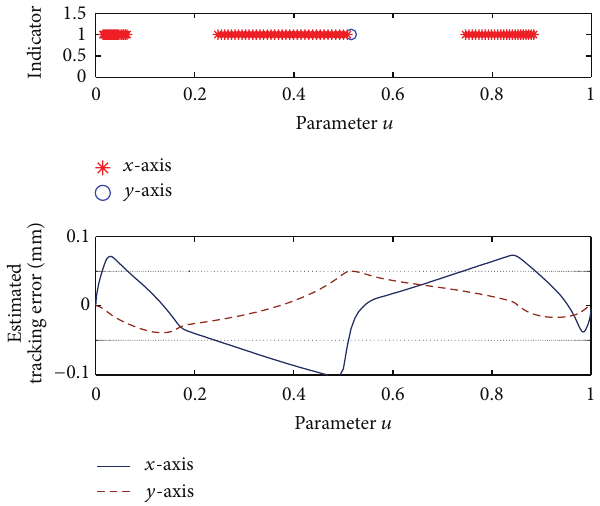
Figure 4: Tracking error estimation at initial iteration of the pro- posed strategy and the corresponding active constraints indicator of tracking error